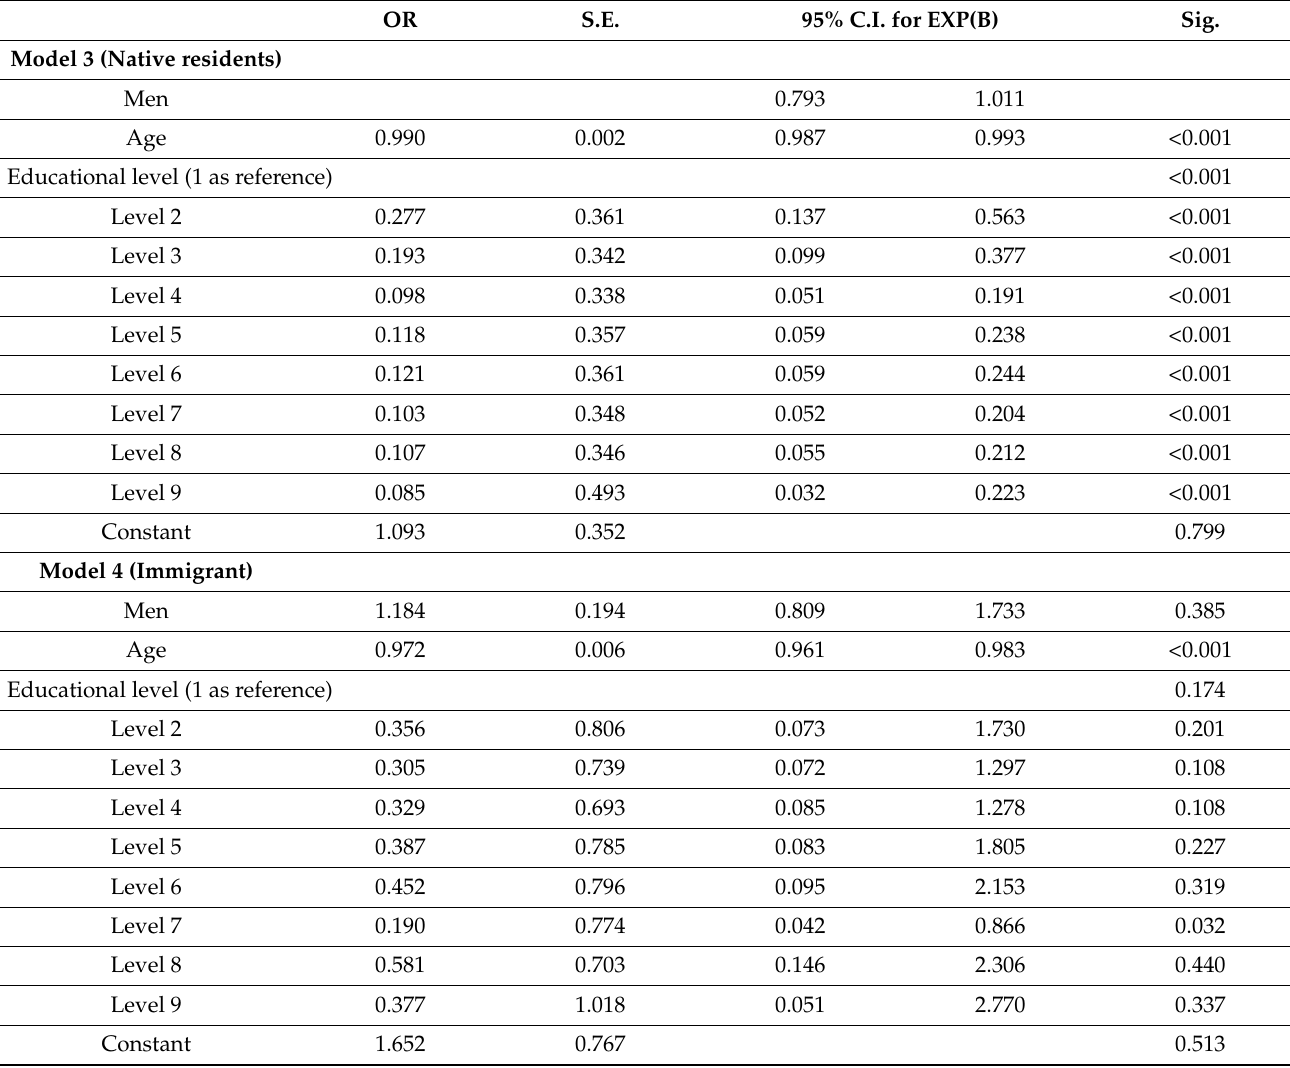
Table 3. Stratified logistic regression